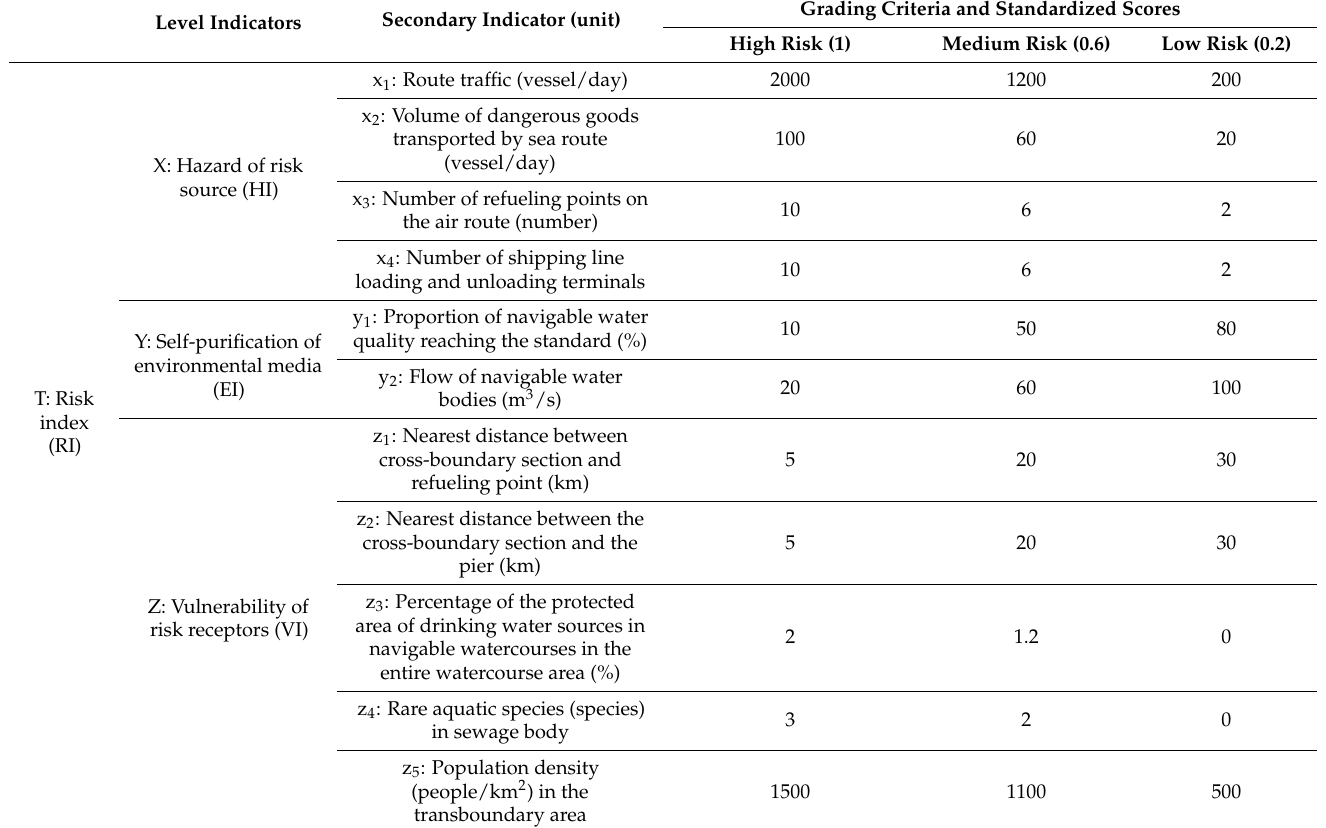
Table 5. Risk assessment index system for transportation sources in cross-border